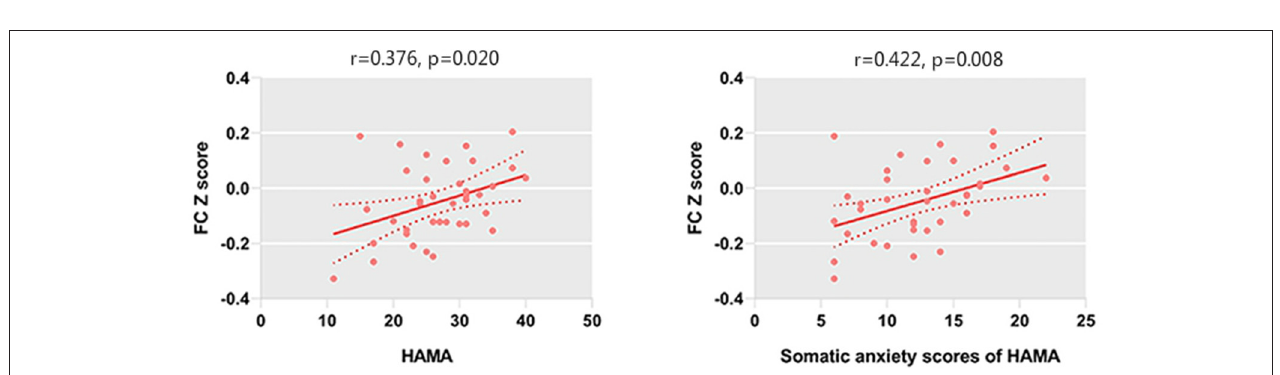
FIGURE 2 | FC between the left amygdala and left rACC is negatively correlated with the HAMA scores, psychic anxiety scores of the HAMA, GAD-7 scores, and TAI scores.